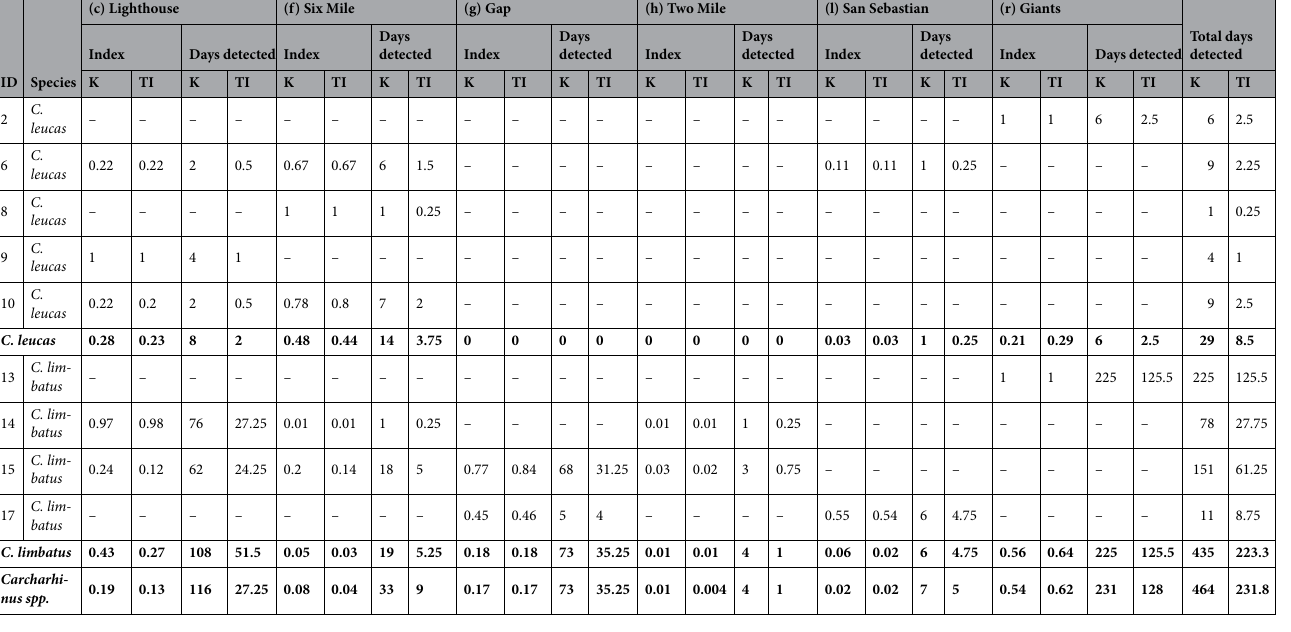
Table 2. Residency indices for each acoustic receiver location that recorded sharks tagged with acoustic transmitters. Only sharks with one recorded detection at least one receiver site are included, otherwise the values are zero. The letter K denotes the Kessel method (Distinct number of days detected at the location/ distinct number of days detected at any location) whilst the letter TI indicates the Time Interval method (600 s (see “Methods”)) (Distinct number of time intervals detected at this location / distinct number of time intervals detected at any location). The Index headings refers to residency indexes calculated using the Kessel (K) and Time Interval (TI) methods. The Days Detected heading refers to the number of days and/ or proportion of the day that sharks were detected around a particular receiver. Labels (c, f, g, h, l, r) refer to locations illustrated in Fig. 1. Significant values are in [bold].